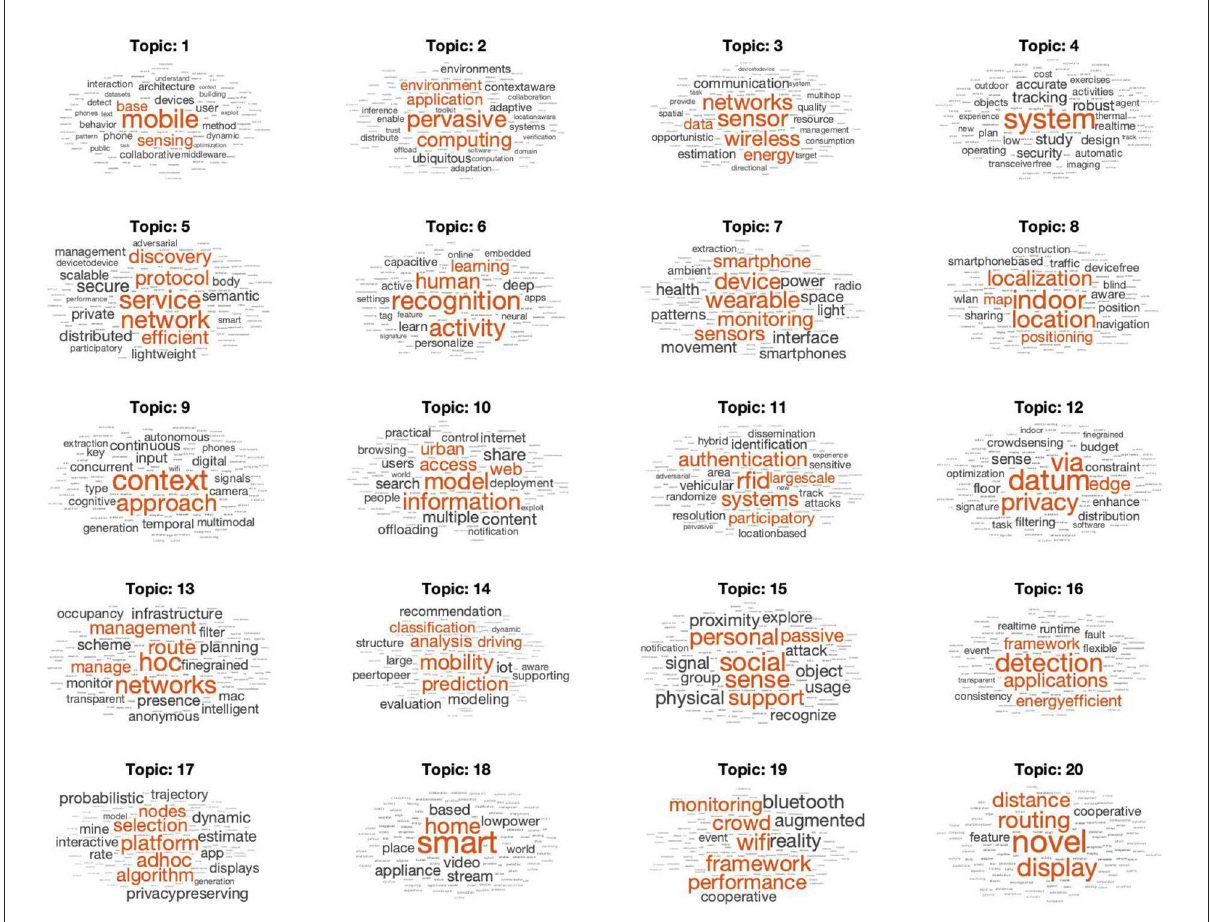
FIGURE4 Topics of the dataset of 610 PerCom articles, based on their titles. The most influential words of each topic are highlighted.